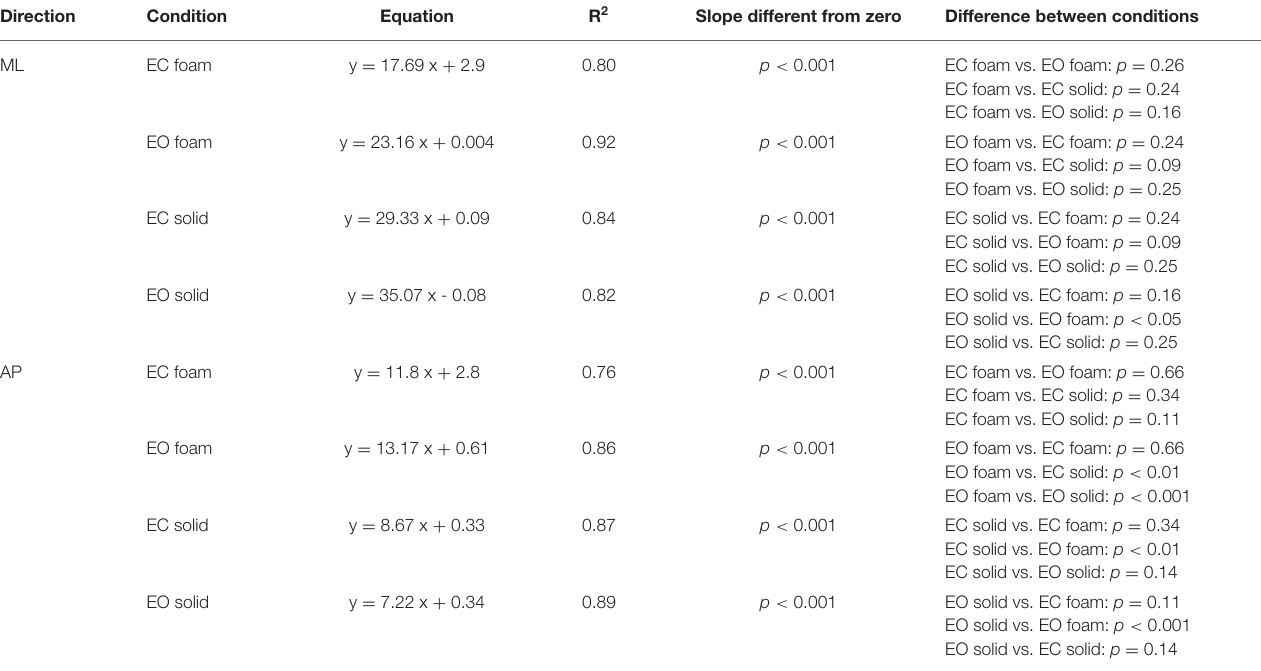
TABLE 4 | Relationship between Path Length and CoP SD 2 . Direction